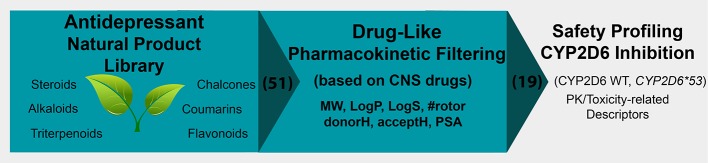
The in silico safety profiling approach of the natural product antidepressant library.